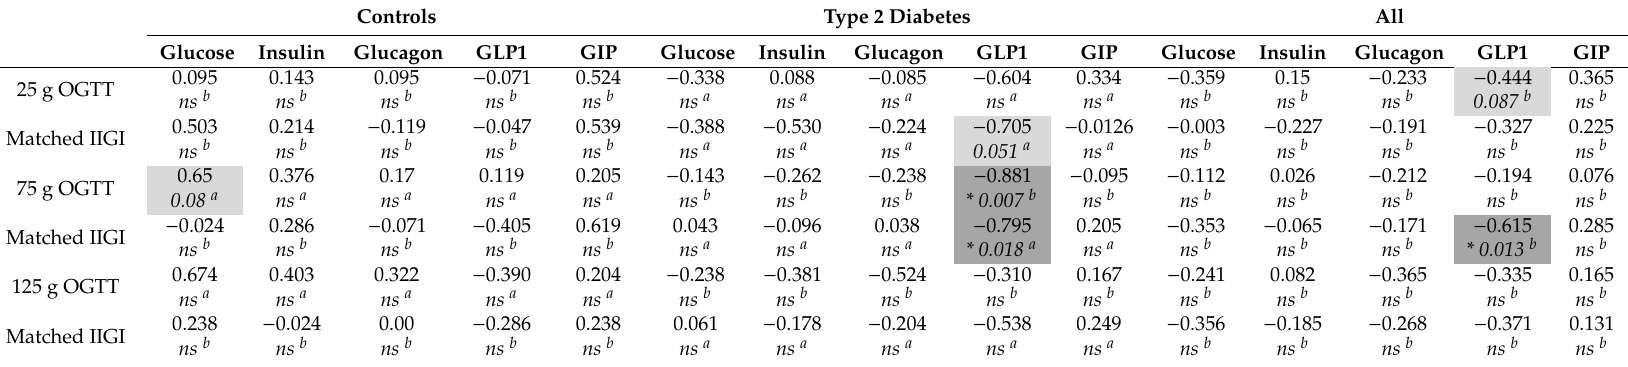
Table 3. Univariate relationships between AUC 0–240 min for sRAGE with AUC 0–240 for glucose, insulin glucagon, and incretin hormones GLP-1 and GIP. Controls Type 2 Diabetes